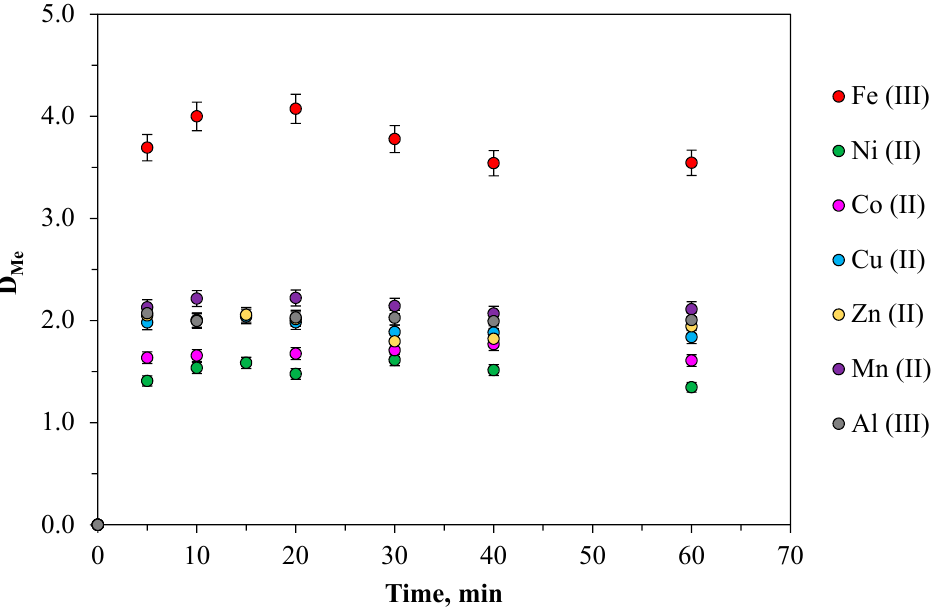
Figure 1. Effect of the phase contact time on the metal extraction in PEO 1500 (16.3 wt%)-NaNO 3 (36.0 wt%)-H 2 O system: [Me] in = 0.01 mol · L − 1 ; the temperature was 298.15 K, the phase ratio: 1:1.